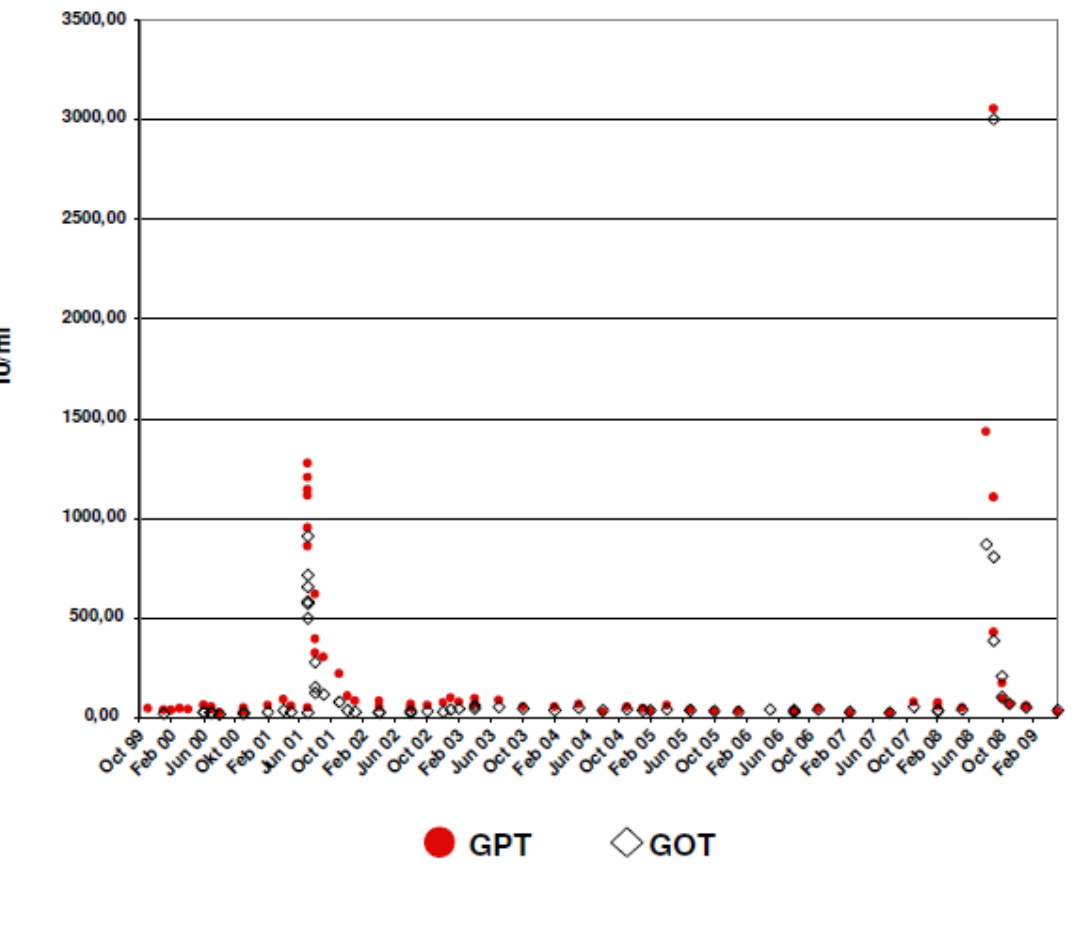
Figure 1. Fluctuation of liver enzymes throughout the whole observation period (IU/ml). GPT = ALT, GOT =